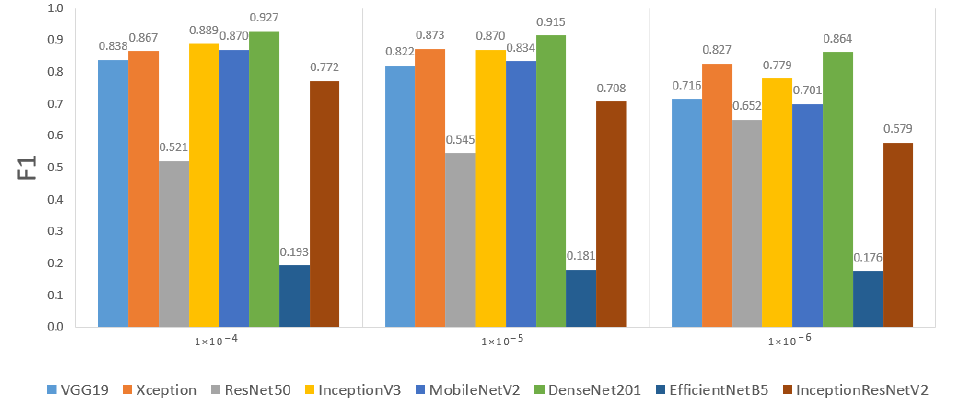
Figure 7. Summary of evaluation results by learning rate and model type, in terms of